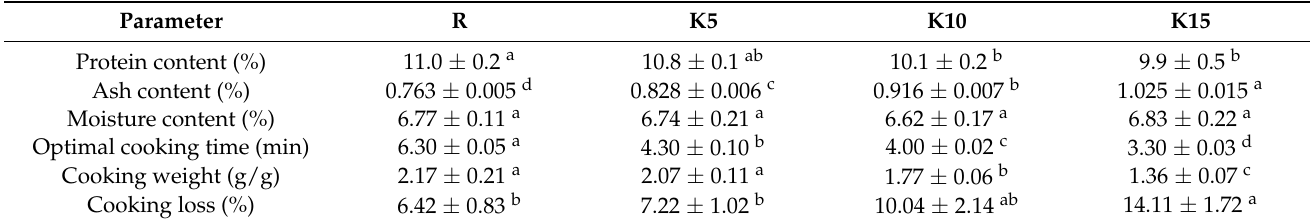
Table 2. Proximate composition and cooking behavior of analyzes